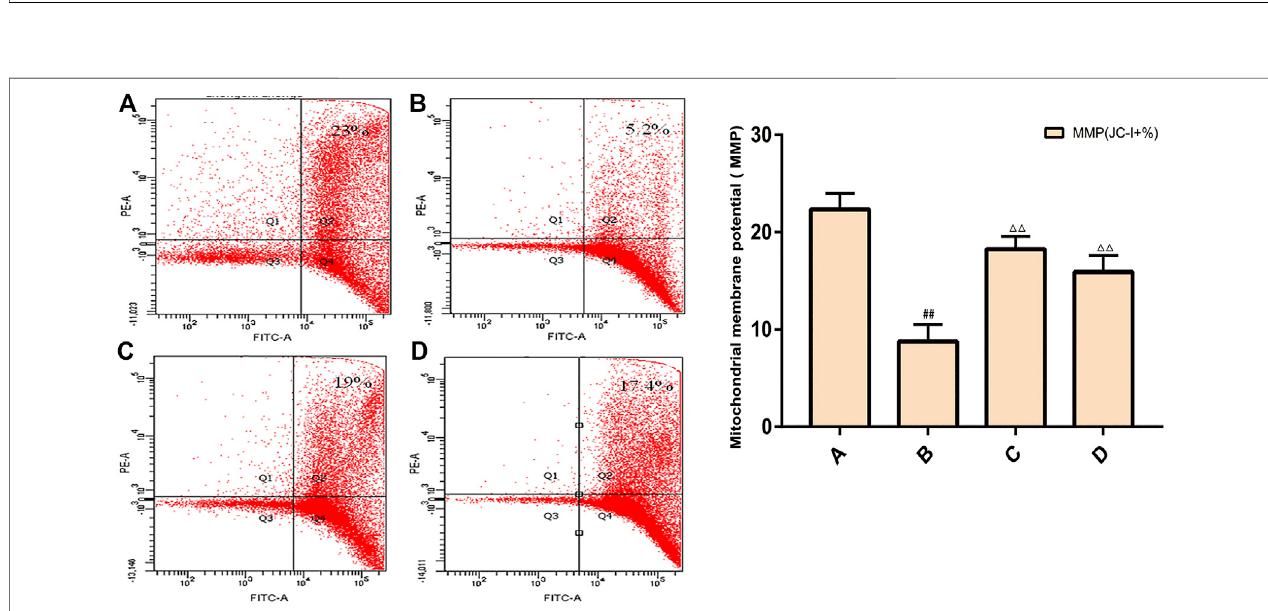
FIGURE 13 | Rat spermatogenic cell MMP. (A) : normal group; (B) : model group; (C) : ZBDHD group; (D) : positive control group. Compared with normal group ## p < 0.01; compared with model group, △△ p < 0.01.